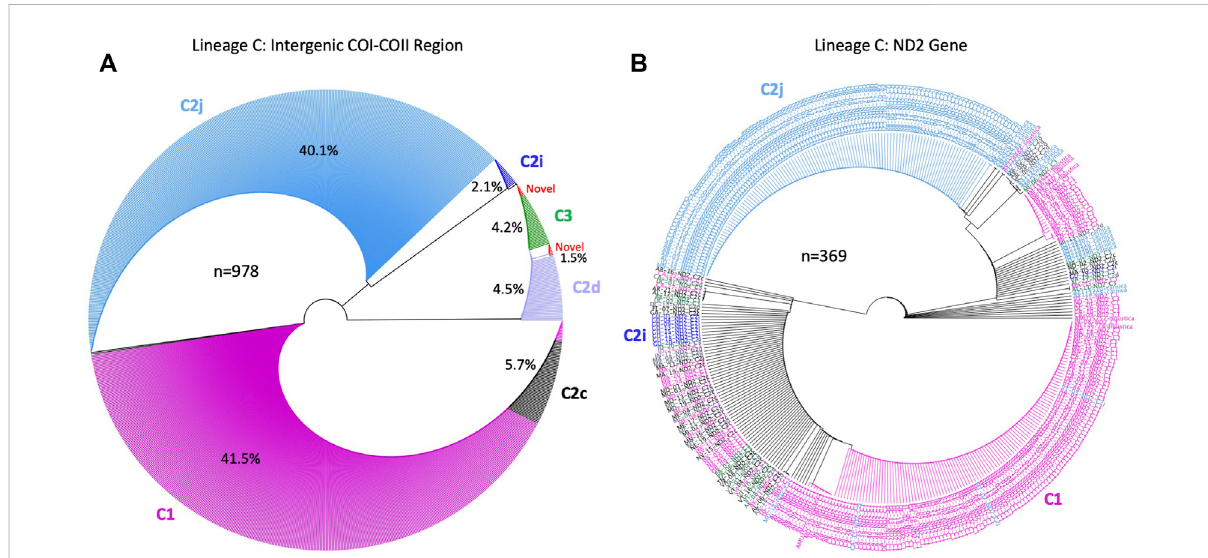
FIGURE 5 Phylogenetic analysis conducted onsequencesoftheClineage intwomtDNAgeneticregions: (A) :COI – COIIintergenicregionand (B) :NADH dehydrogenase 2 (ND2) coding gene (n) is the number of sequences run in each phylogenetic tree, contribution of each COI-COII haplotypes is given in (%). ND2 sequences in (B) were labeled with their respective COI-COII haplotypes identi fi ed in (A) . Analyses were computed with available NCBI sequences of the C lineage for both